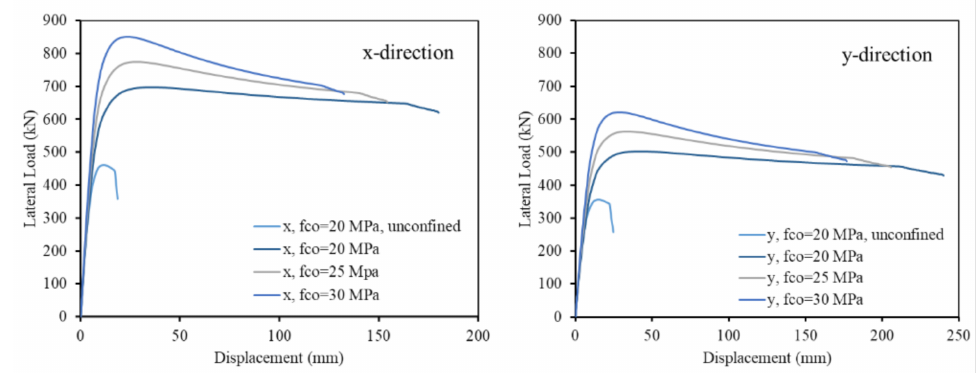
Figure 13. Lateral load-displacement curves by the concrete strength (rectangular cross-section).